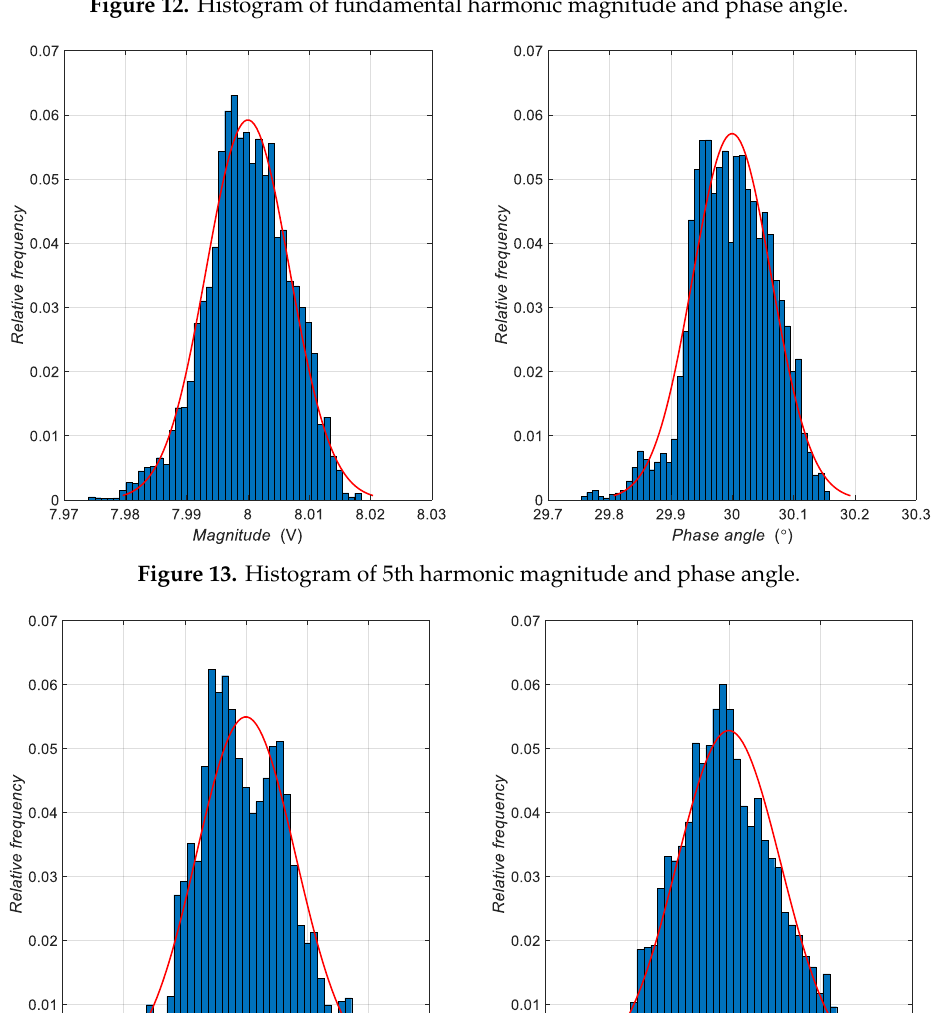
Figure 12. Histogram of fundamental harmonic magnitude and phase angle. Energies 2019 , 12 , x FOR PEER REVIEW